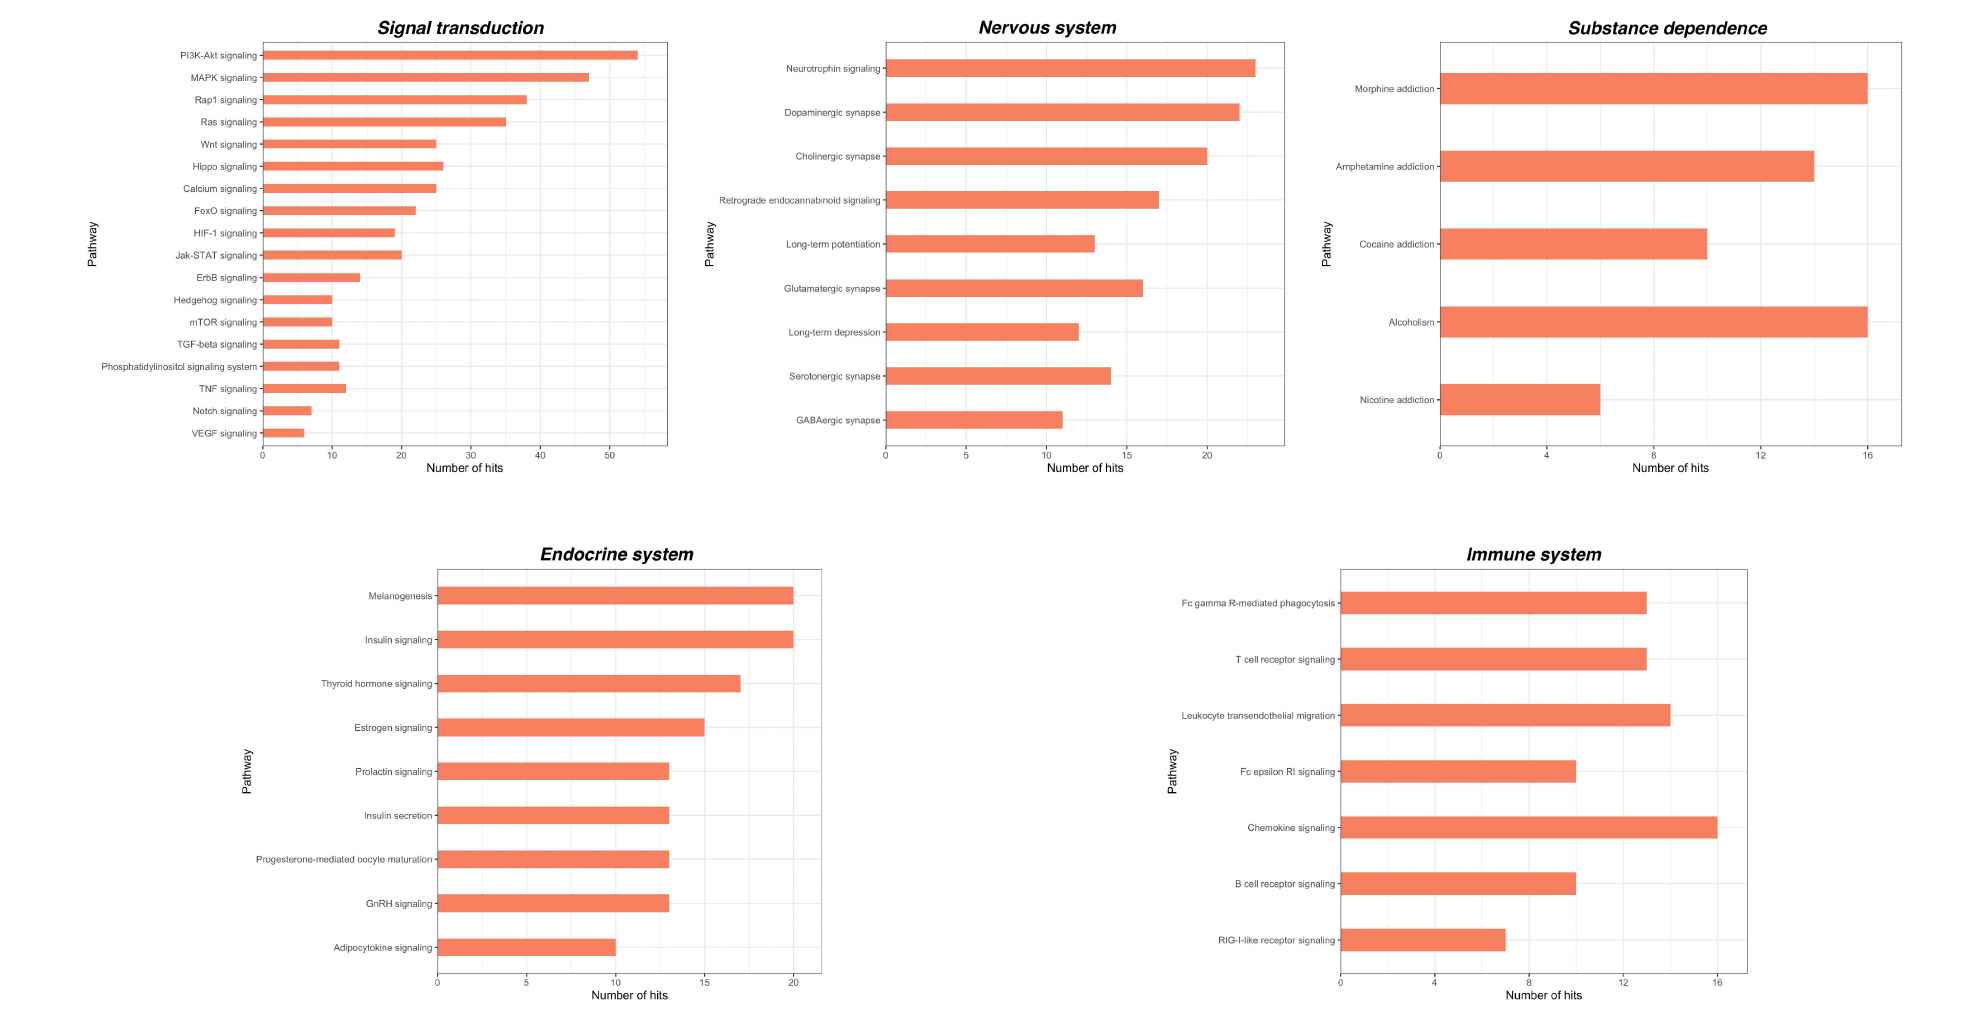
Figure 2. KEGG pathways related to cellular processes significantly associated with miRNA targets in CPP (within each group, pathways are arranged according to their p -values, in descending order). Adjusted p -values were calculated using Benjamini-Yekutieli method.